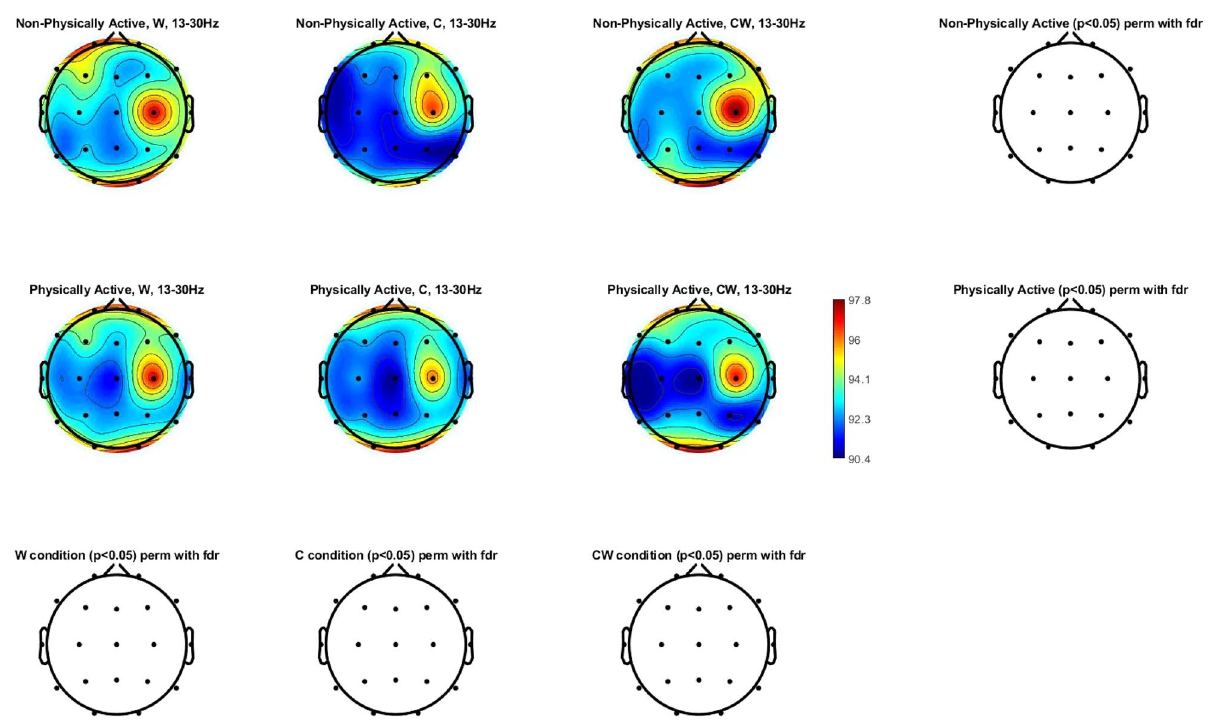
Figure 4. Beta power spectrum (13–30 Hz) topographic maps in physically and non-physically active women with FM. Differences were not found (p > 0.05) in any of the scalp locations. W names of colors printed in black,